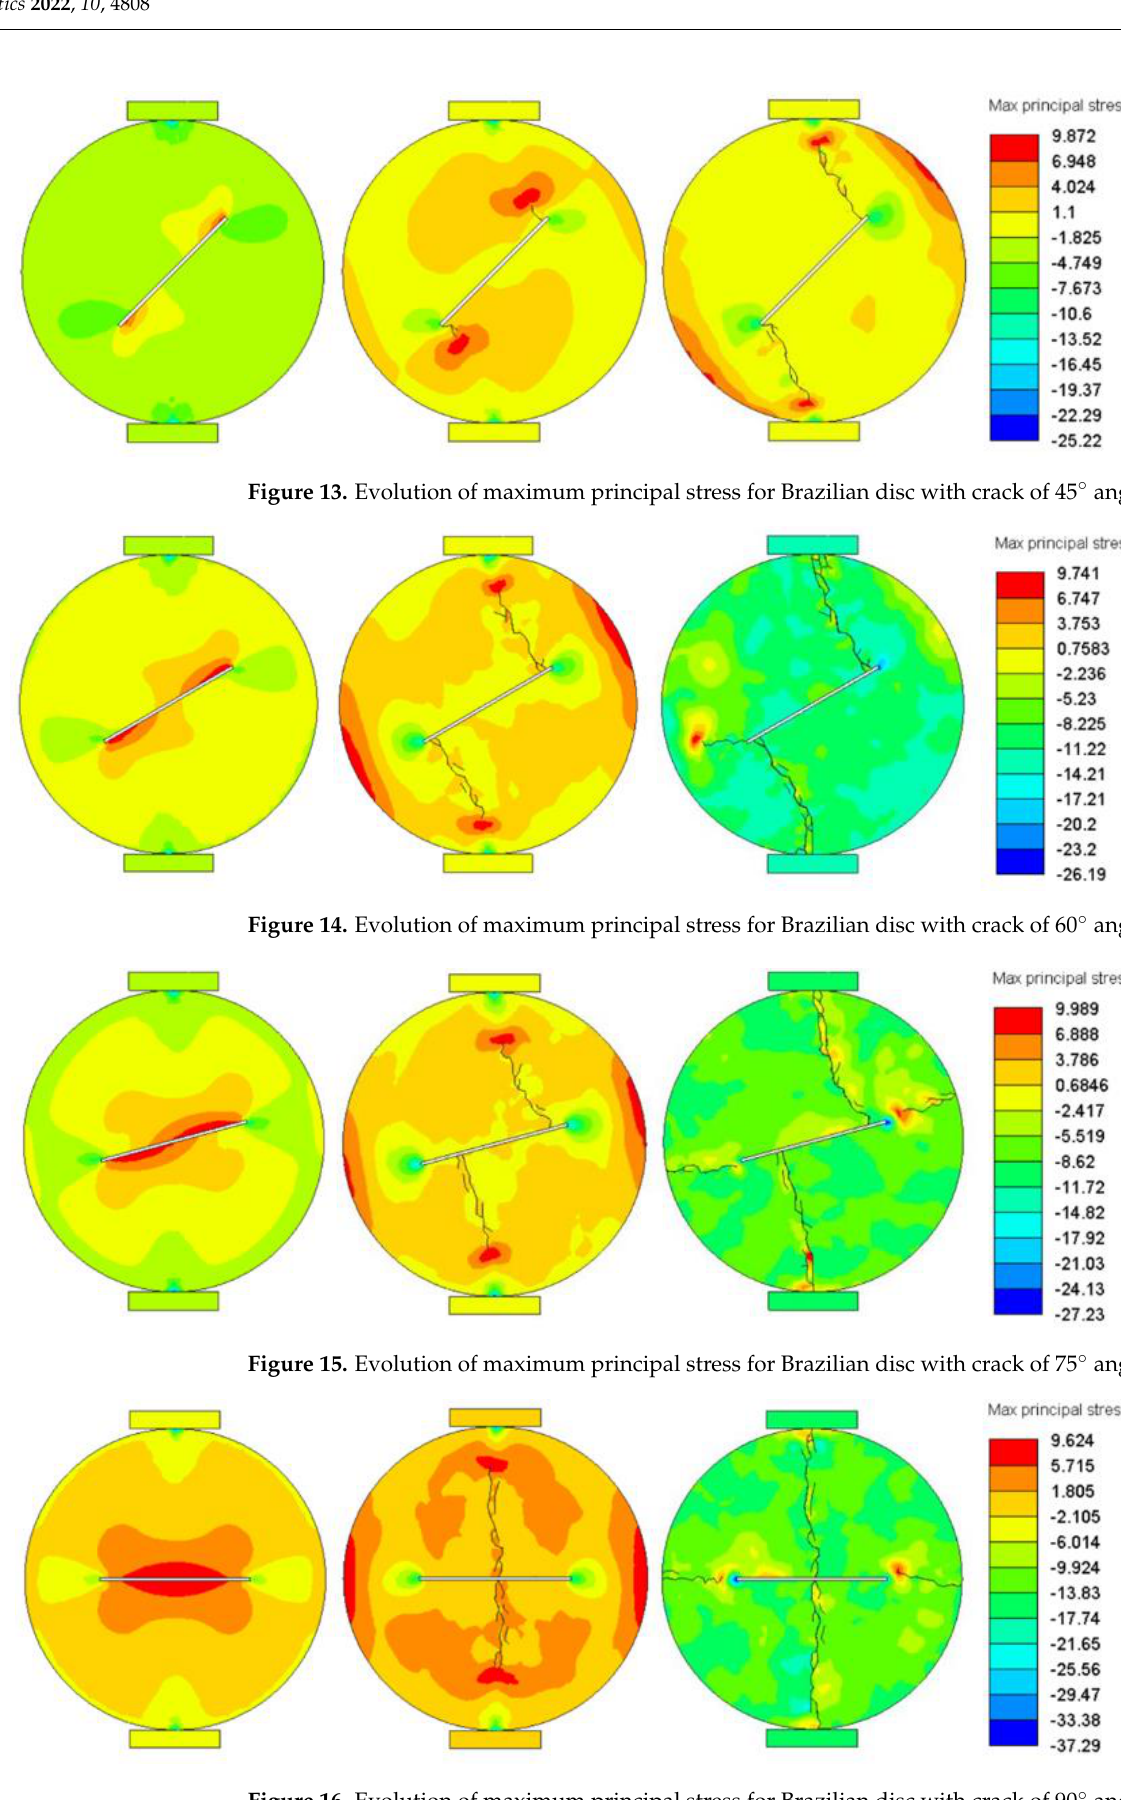
Figure 16. Evolution of maximum principal stress for Brazilian disc with crack of 90° angle.